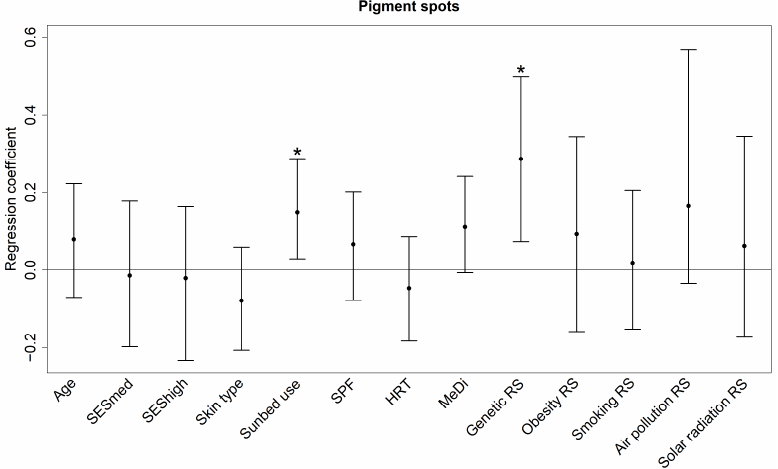
Figure 2. Regression coefficients (bootstrap medians and 95% percentile confidence intervals) of the predictors for pigment spots. The coefficients reflect the change in the z-score for one unit increase in the single predictors and one interquartile range increase in the risk scores. MeDi: Mediterranean diet; HRT: hormone replacement therapy; RS: risk score; SESmed: medium socio-economic status